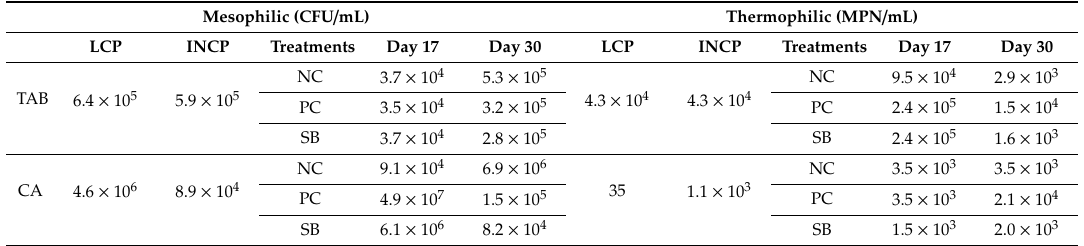
Table 3. Counting groups of bacteria at mesophilic and thermophilic